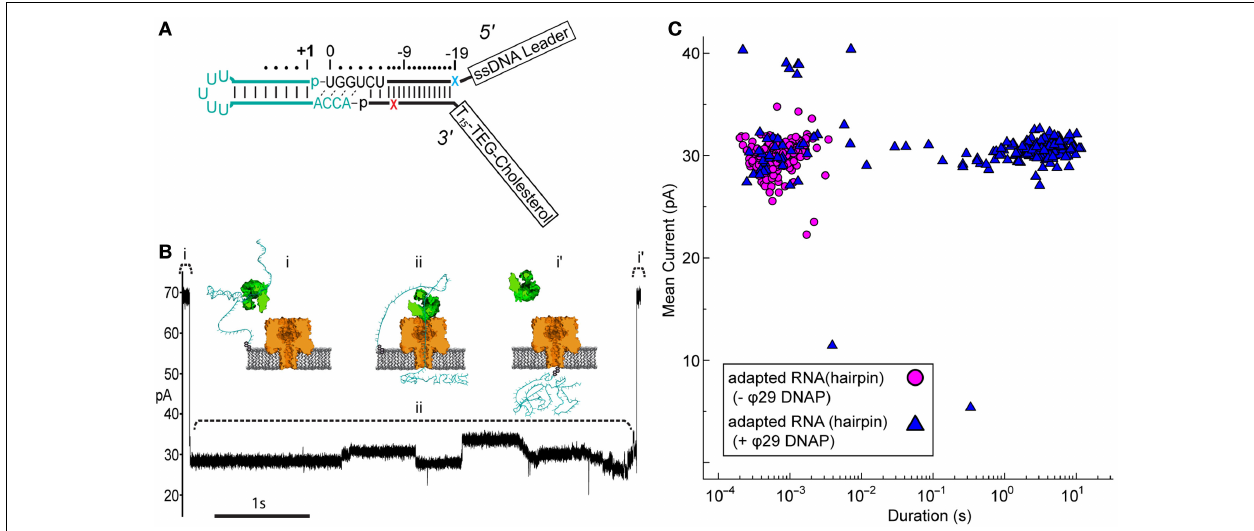
FIGURE 3 | Nanopore capture of adapted RNA complexed with non-catalytic ϕ 29 DNAP . (A) Schematic of the synthetic RNA(hairpin) construct (cyan) covalently attached to the adapter (black). This simple RNA hairpin is composed of a synthetic copy of the E. coli tRNA fMet acceptor stem linked by a five uracil loop. This RNA was enzymatically ligated to the adapter as described previously (see Materials and Methods). Colored X’s indicate 5 ′ (blue) and 3 ′ (red) abasic residues in the adapter strands. (B) Representative ionic current trace during capture of an adapted RNA hairpin complexed with ϕ 29 DNAP. ϕ 29 DNAP (75nM) and adapted RNA (0.5nM) were added to cis side compartment which contained nanopore